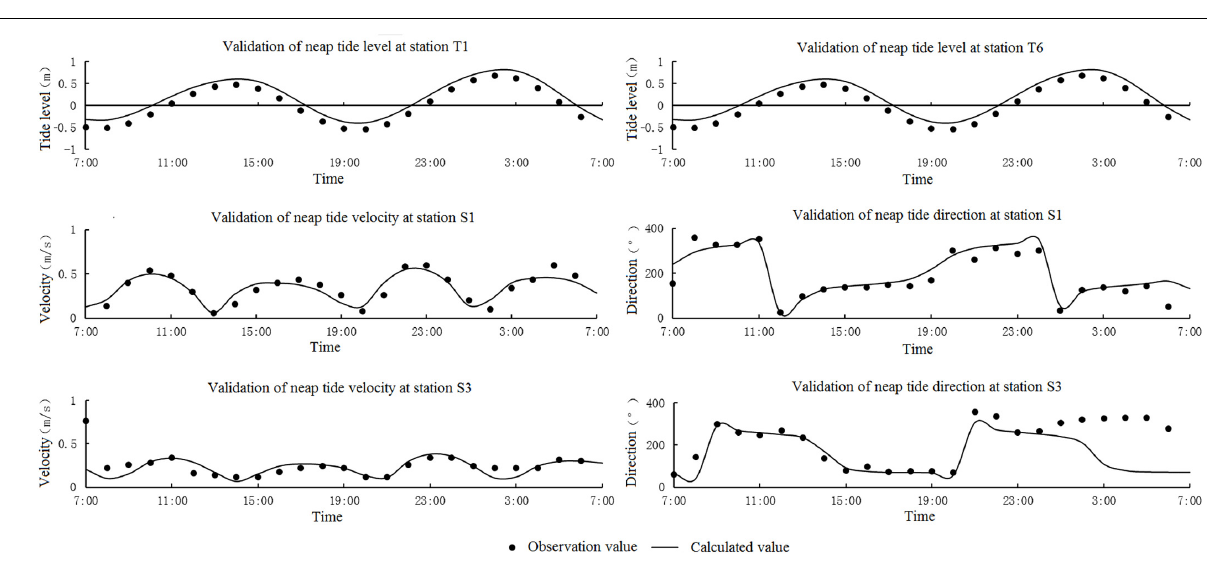
FIGURE 4 | Validation of tide level, current velocity, and direction in Bohai Bay (neap